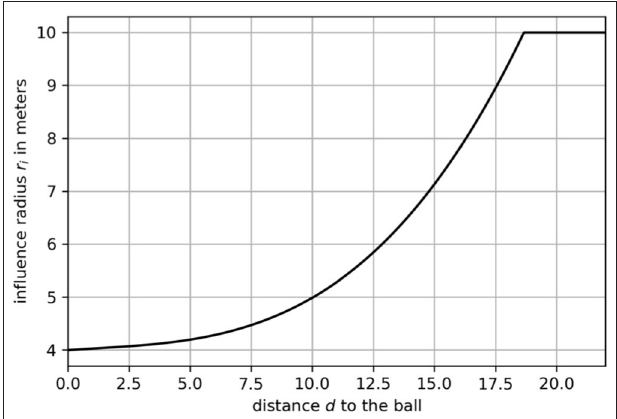
FIGURE 2 | A function that maps the distance d to the influence radius r i